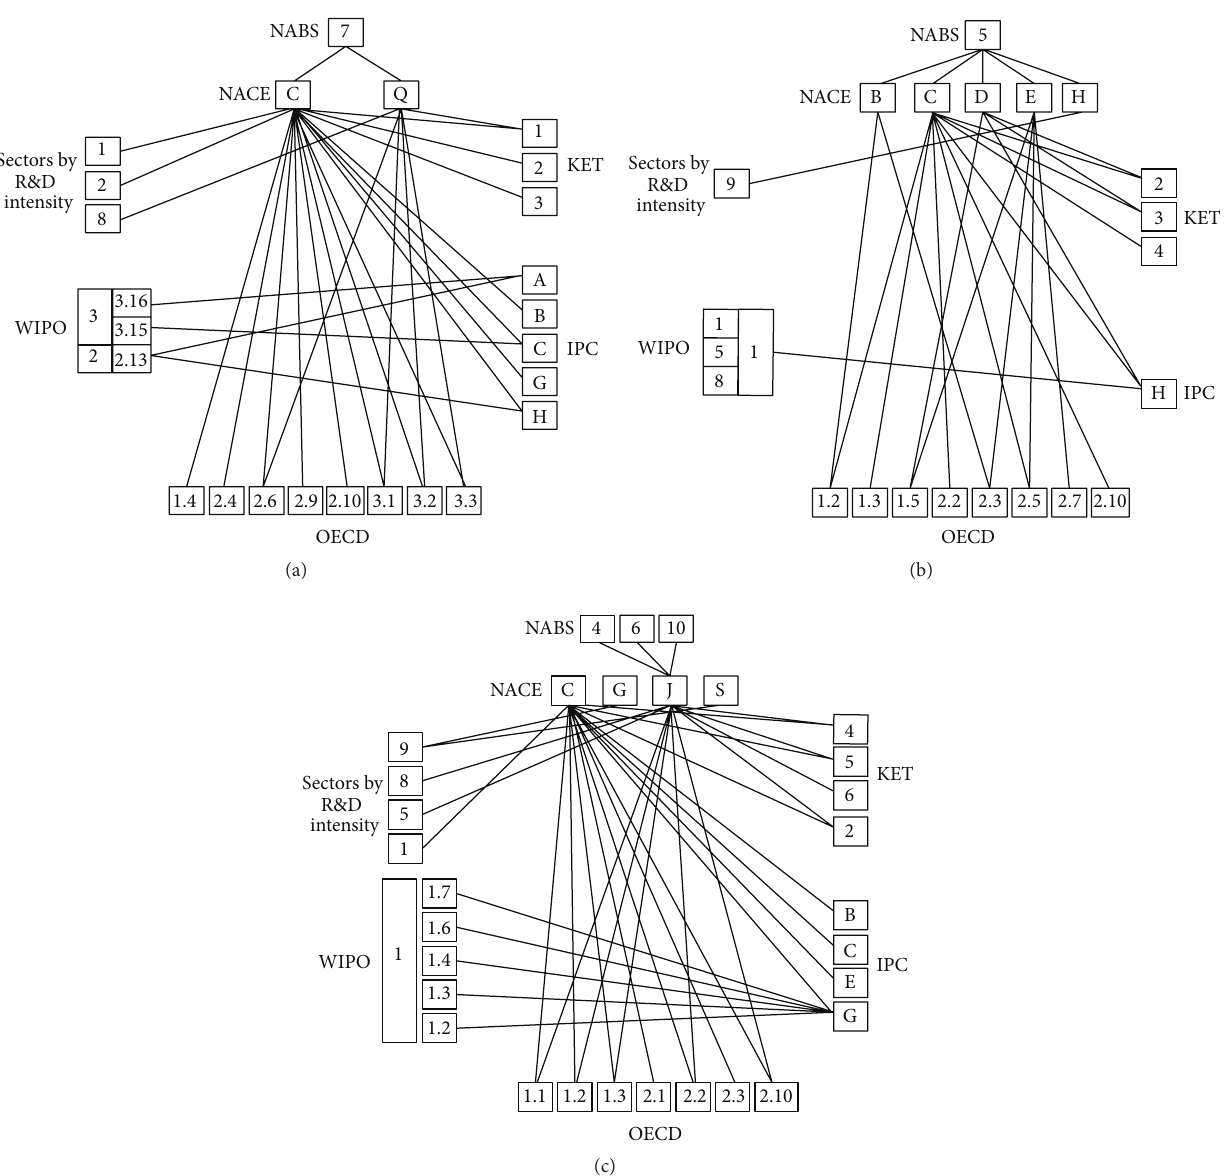
Figure 1: Concordance matrix for regional smart specialization in the field of (a) medicine, (b) power engineering, and (c)